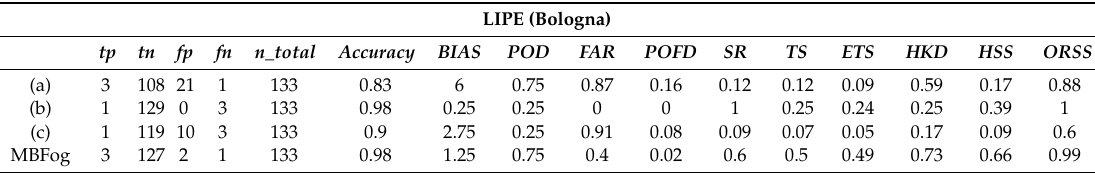
Table A6. Performances of several fog prediction methods for Bologna site LIPE